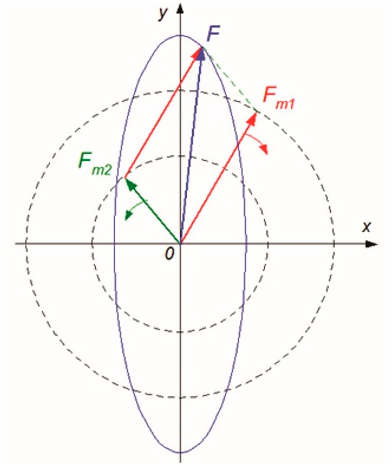
Figure 14. MMF generated by an unbalanced system of electric currents [21].